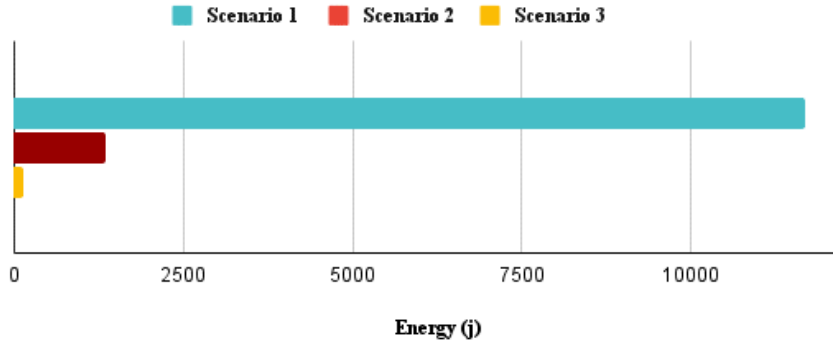
Figure 6. The total energy consumption in the multi-hop scenarios.